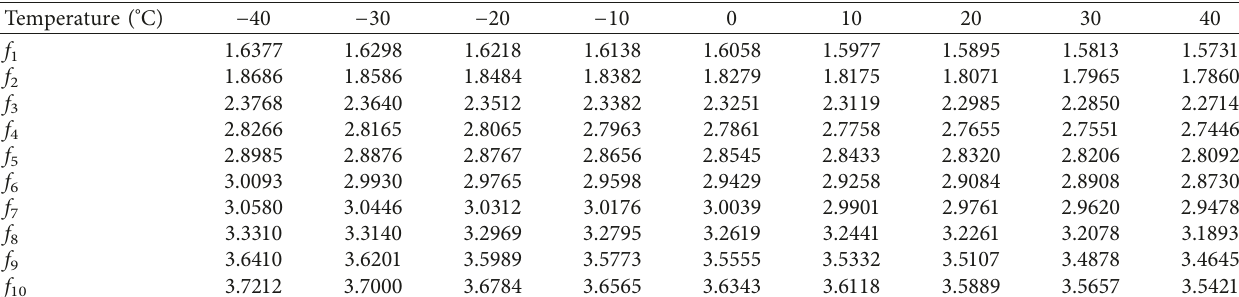
Table 5: Frequency of the first 10 vibration modes of the CSBV with semiparallel steel tendons (unit: